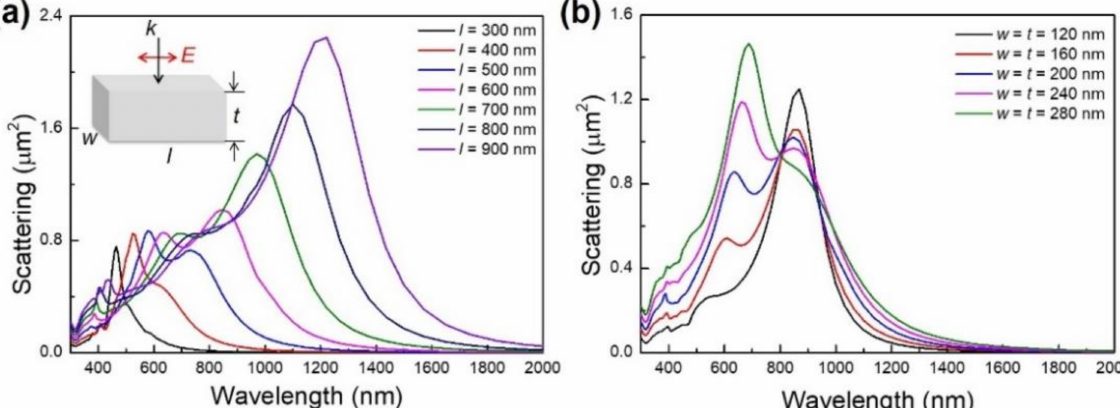
Figure 3. Finite-difference time-domain (FDTD) simulated scattering cross-section of single silver nanobar with various sizes at an incident angle ( θ = 0 ◦ ) in air (RI = 1.0). ( a ) Width and thickness ( w = t = 200 nm) and lengths ( l = 300 nm, 400 nm, 500 nm, 600 nm, 700 nm, 800 nm and 900 nm, respectively). ( b ) Length ( l = 600 nm), width and thickness ( w = t = 120 nm, 160 nm, 200 nm, 240 nm and 280 nm,